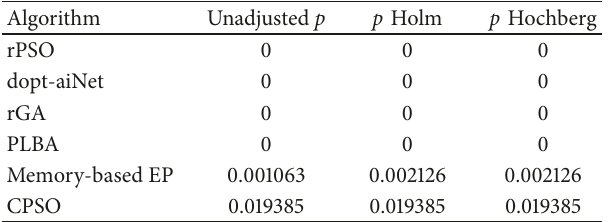
Table 15: Average rankings of PLBA and other algorithms (Fried- man) on dynamic benchmark problems 𝐹 1 – 𝐹 6 in terms of both solution quality and convergence speed.